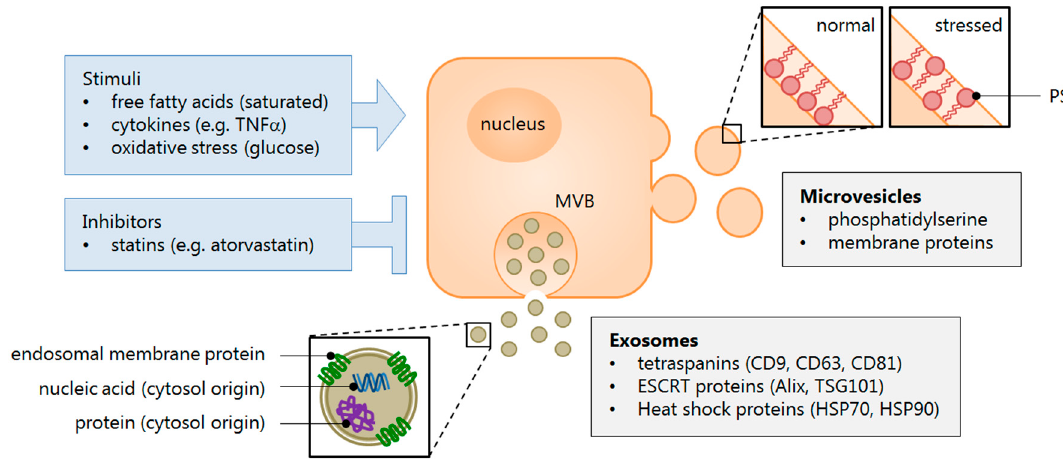
Figure 1. Extracellular vesicle characterisation. Cells respond to a variety of stimuli that cause inflammation and metabolic stress, which result in their activation, impaired functioning, or apoptosis. This mechanism drives the release of extracellular vesicles (EVs), which signal to paracrine or distal effectors the condition of the cell microenvironment. Effector cells may, in turn, respond by selectively imparting regulatory molecules—small nucleic acids (mRNA and miRNA), lipids, and proteins—contained within EVs, that are taken up by the recipient cell. The EV subclasses are identified by membrane markers that denote the site of their biogenesis. Exosomes typically express endosomal membrane proteins, such as tetraspanins, while microvesicles are understood to contain phosphatidylserine. These lipoproteins are normally oriented towards the cytosol to maintain the cell membrane asymmetry, but during conditions that stimulate EV release, the molecules become everted. Abbreviations: ESCRT = endosomal sorting complex required for transport; MVB = multivesicular body; PS = phosphatidylserine.